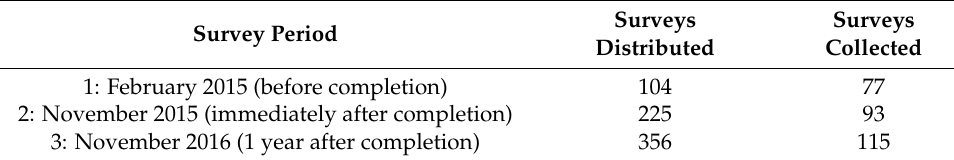
Table 3. Questionnaire